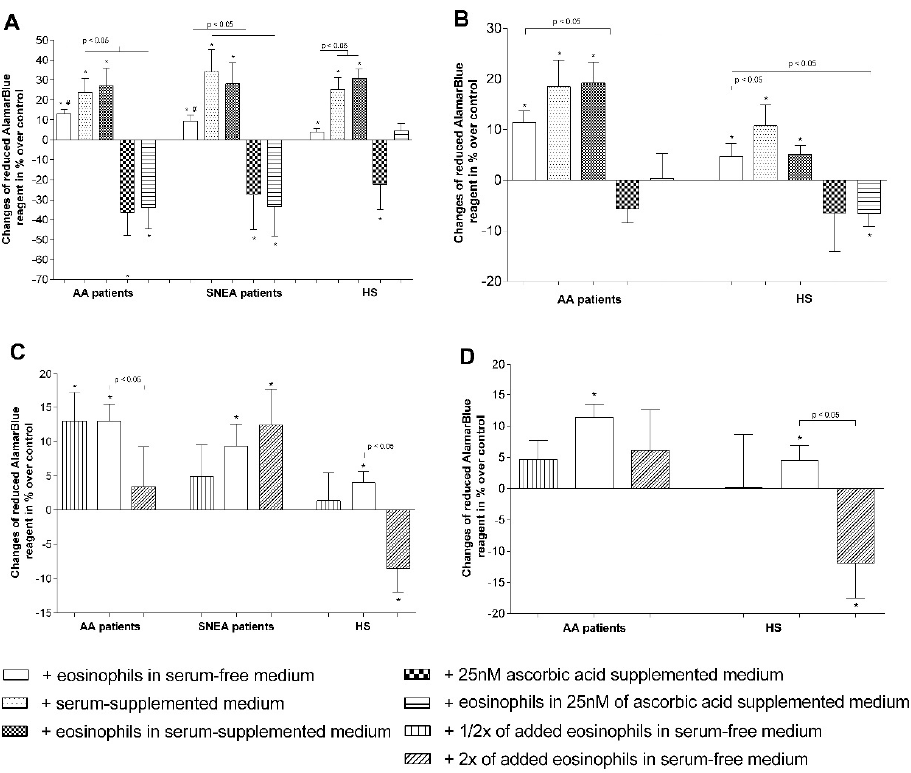
Figure 6. Eosinophils’ effect on pulmonary structural cell proliferation. ( A ) Eosinophils’ effect on ASM cell proliferation; ( B ) eosinophils’ effect on pulmonary fibroblast proliferation; ( C ) the effect of adding a different eosinophil count on ASM cell proliferation; ( D ) the effect of adding a different eosinophil count on pulmonary fibroblast proliferation. Results from independent experiments of AA— n =